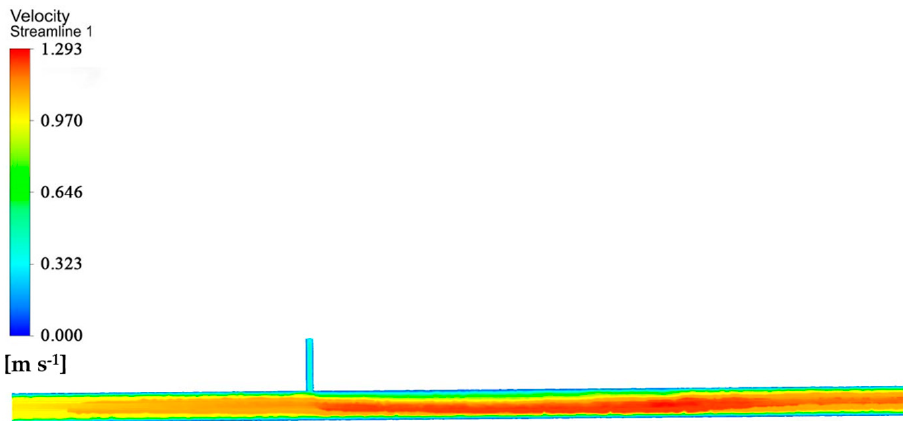
Figure 8. Flow velocity of the longitudinal section at 3.5 s.